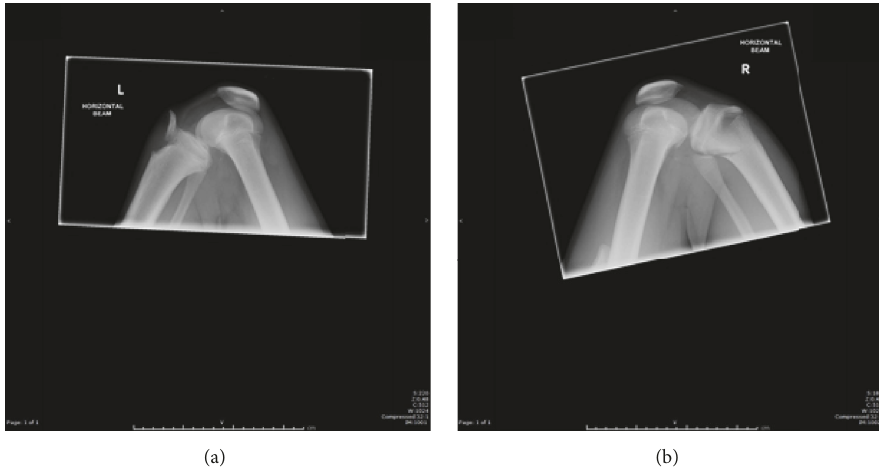
Figure 3: Plain radiographs of left (a) and right (b) proximal tibial avulsion fractures,